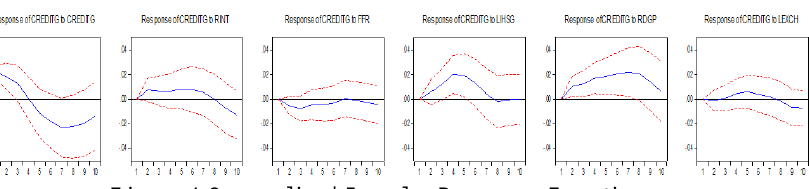
Figure 4 Generalized Impulse Response